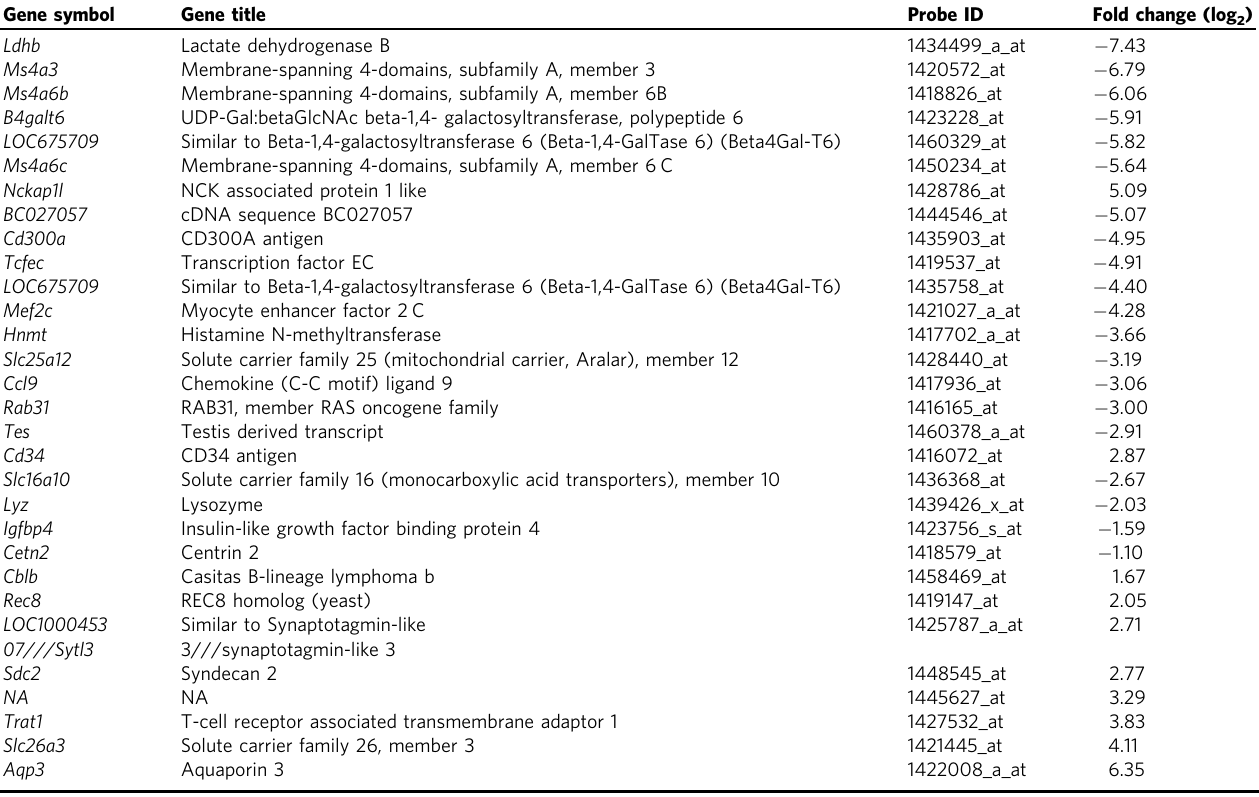
Table 2 All genes signi fi cantly dysregulated in PU.1 mutant GMP-like cells.